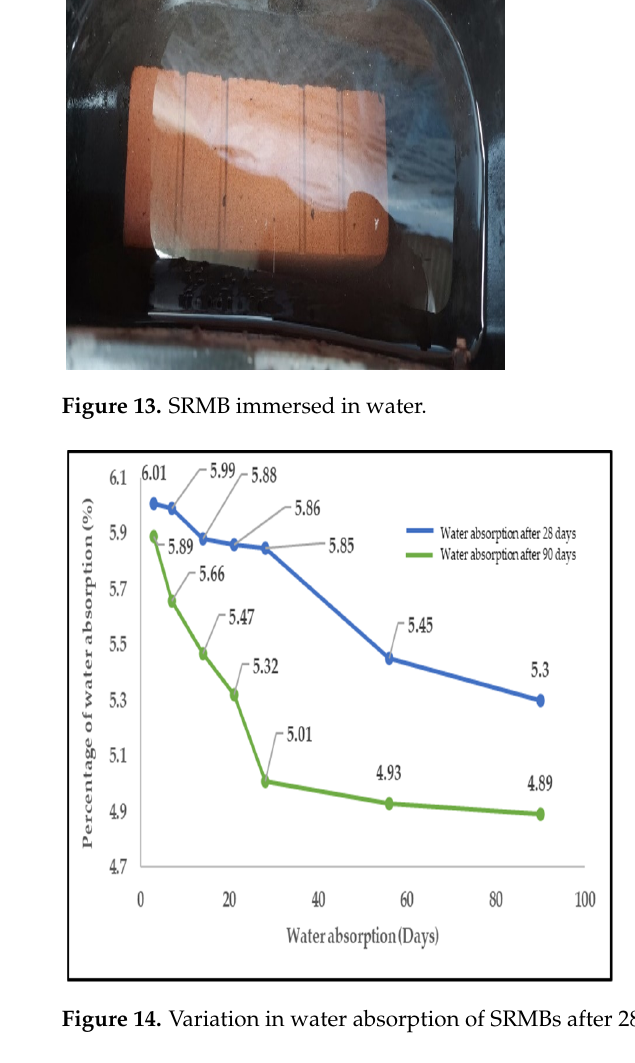
Figure 15. Variation in compressive strength over curing period of SRMBs.